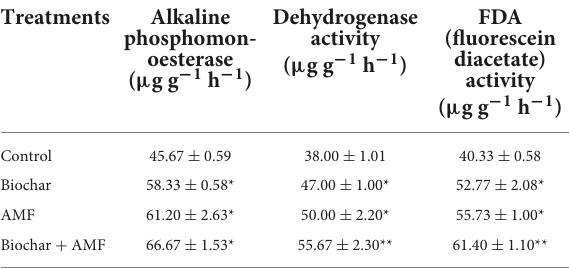
TABLE 4 Soil enzymes activities in soil affected by biochar and AMF under drought